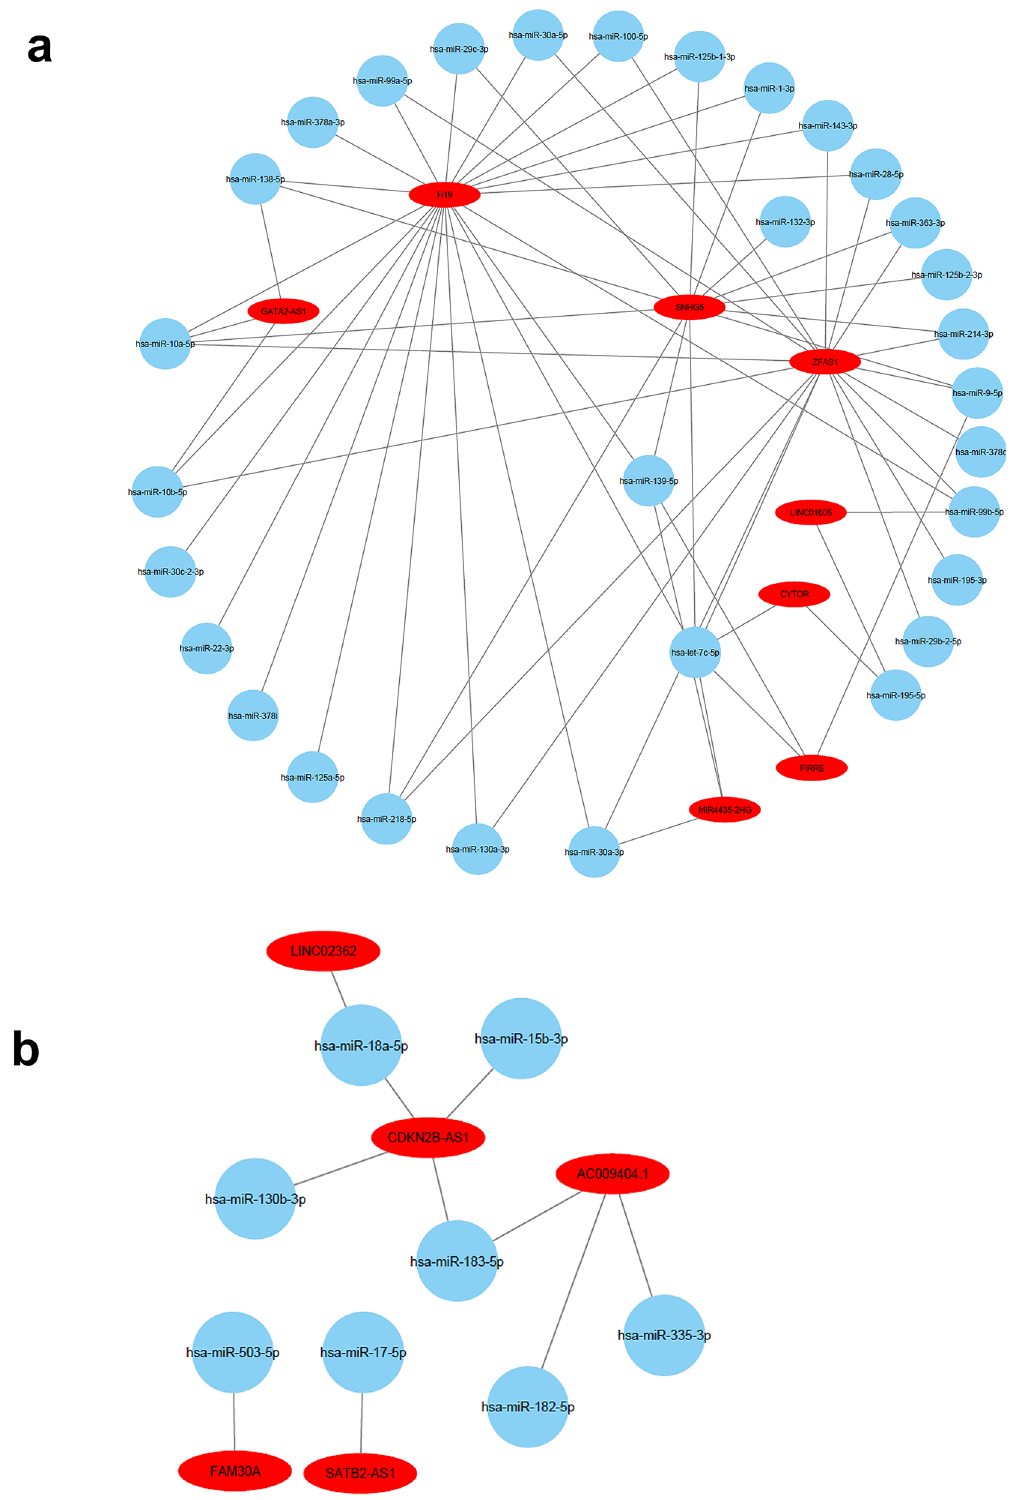
Figure 7. Networks illustrating the interactions between differentially expressed miRNAs and lncRNAs in CRC. (a) Network illustrating the interaction between downregulated miRNAs and upregulated lncRNAs in CRC based on DIANA-LncBase v3. 0. (b) Network illustrating the interaction between upregulated miRNAs and downregulated lncRNAs in CRC based on DIANA-LncBase v3.